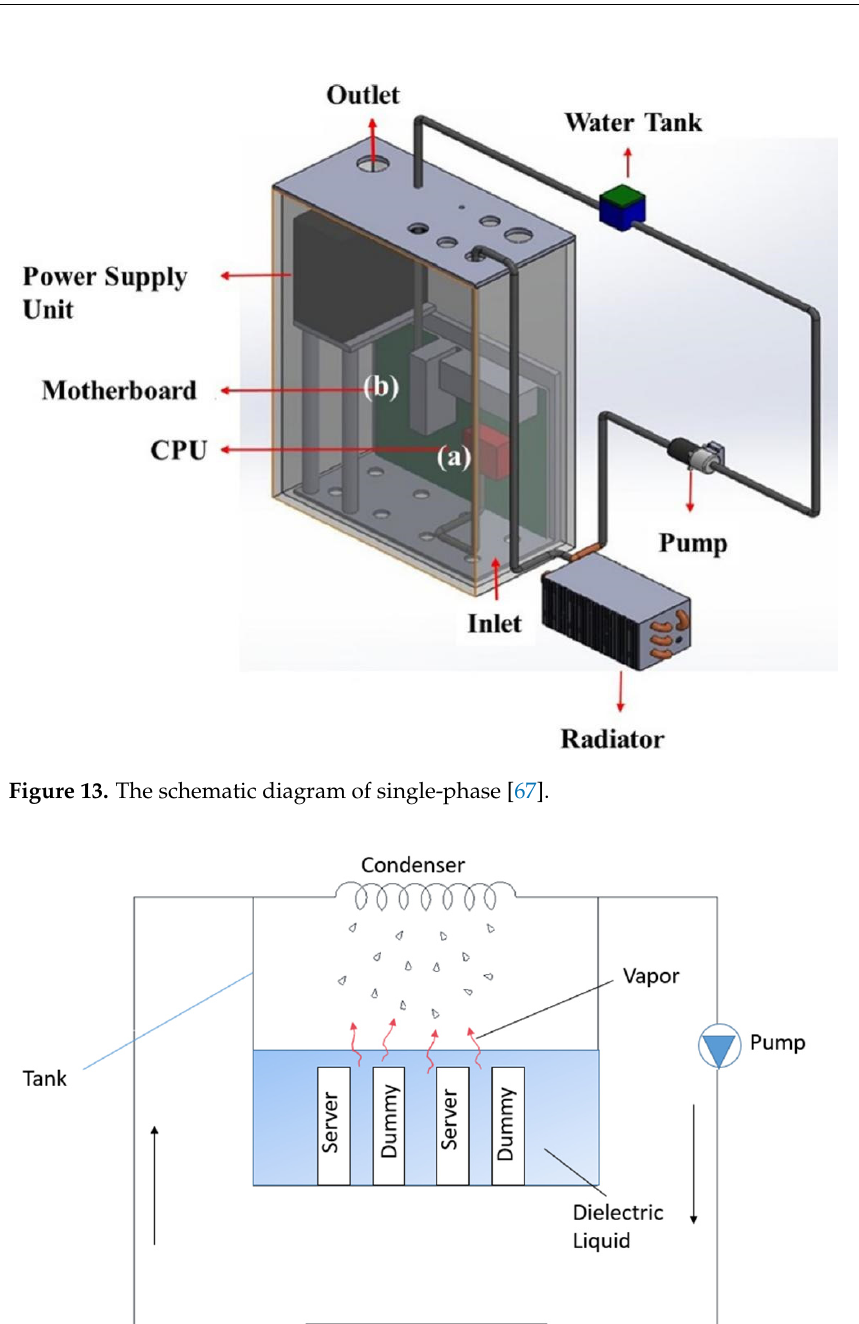
Figure 14. The schematic diagram of two-phase [68].